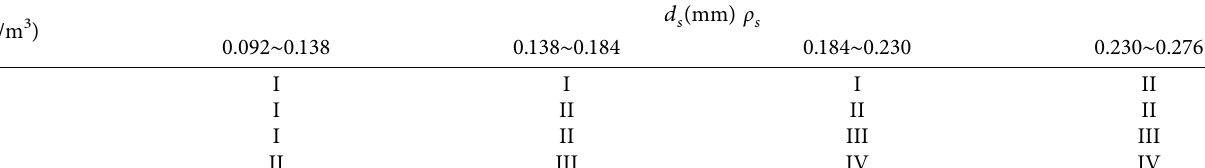
Table 3: Typical shapes and conditions of hysteresis curve at b �